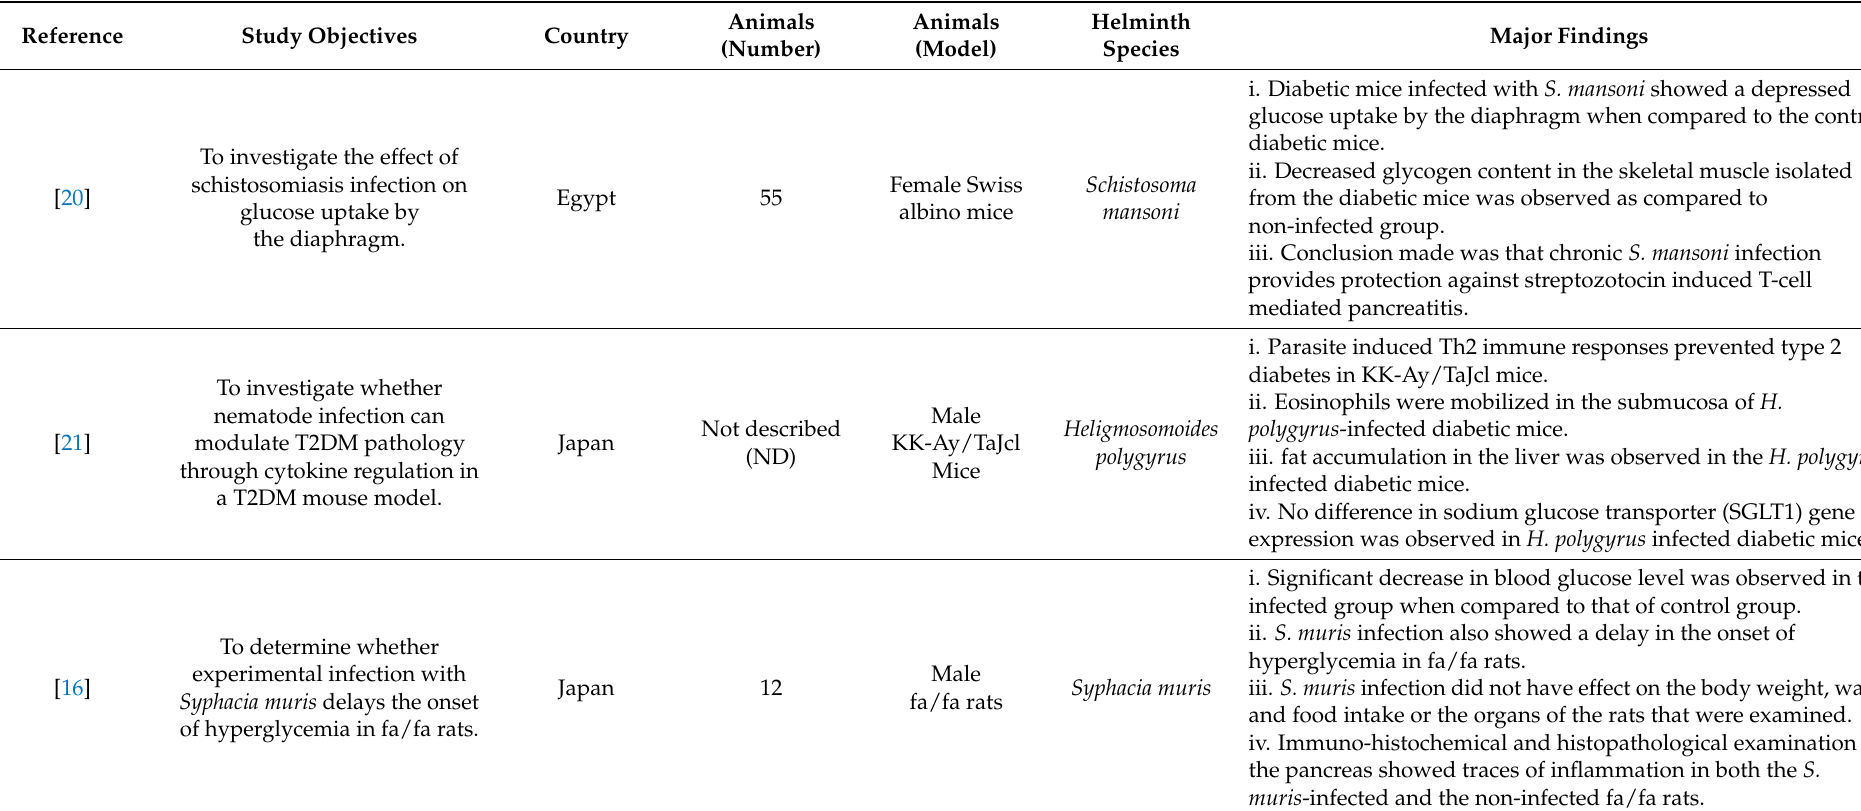
Table 1. Summary of animal studies on helminths infection and type 2 diabetes mellitus comorbidity and the outcomes of the